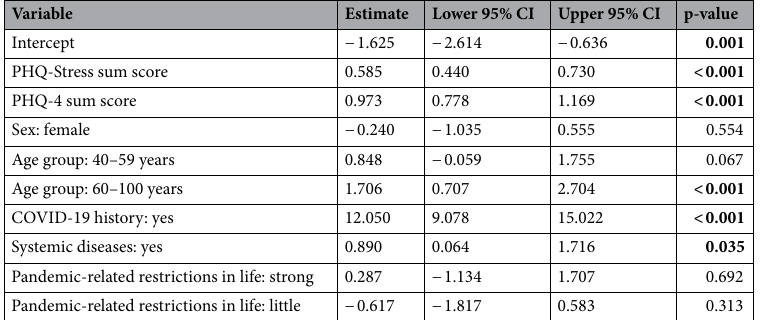
Table 5. Stepwise linear regression result for modeling OHIP-G14 sum score with fixed effects (n = 928). Significant values are in bold. CI confidence interval, OHIP Oral Health Impact Profile, PHQ Patient Health Questionnaire, COVID-19 coronavirus disease